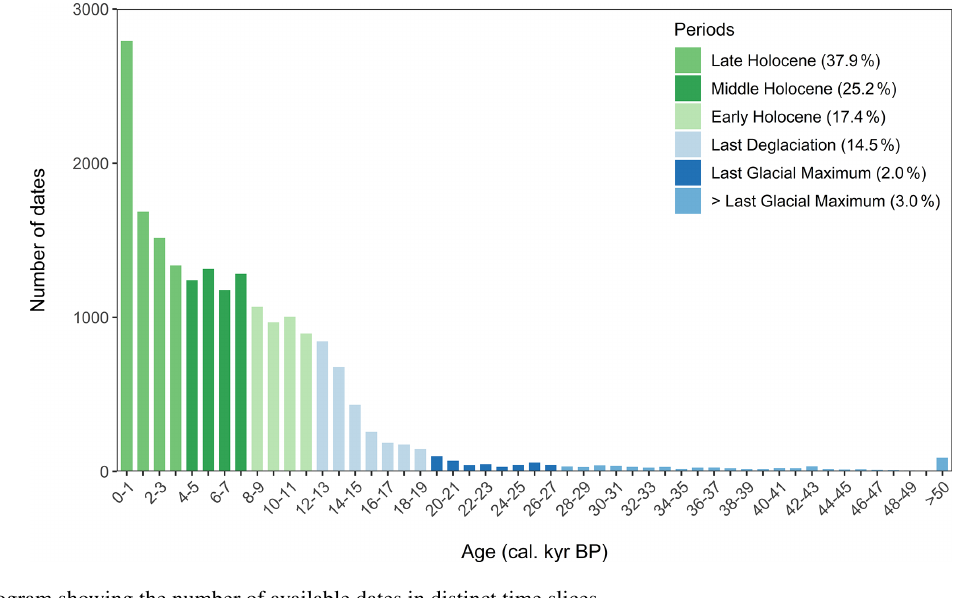
Figure 4. Histogram showing the number of available dates in distinct time slices.